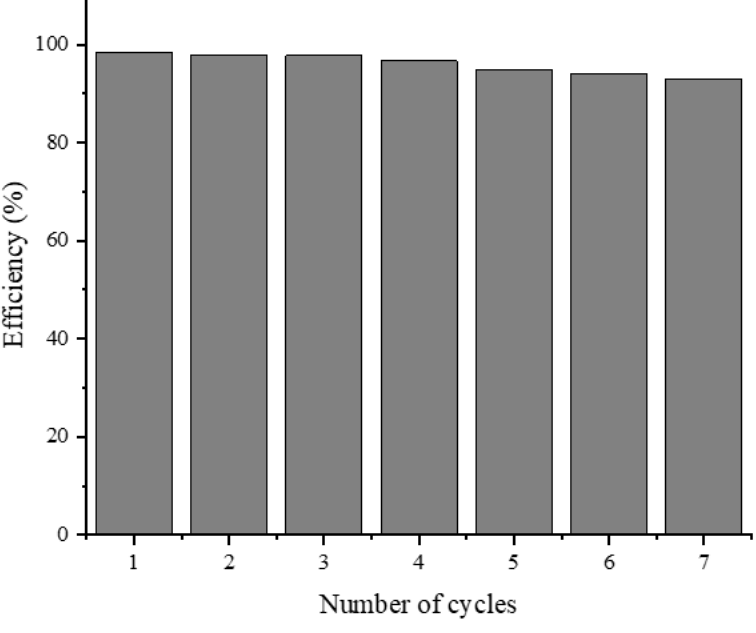
Figure 10. Recycling potential of Fe 3 O 4 /AC/TiO 2 (1:2) for catalytic degradation during the 60-min reaction.